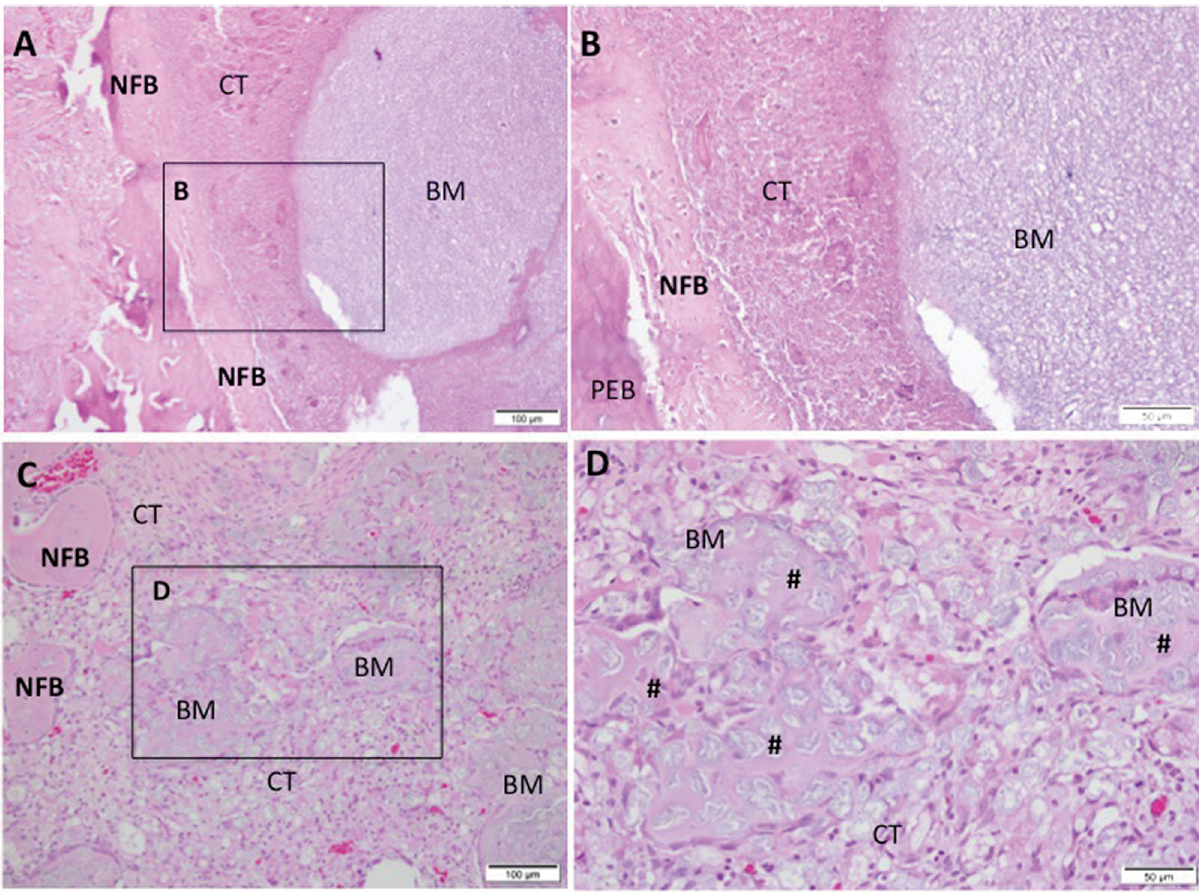
Figure 3- Representative photomicrographs of alveolar socket after 7 days. A and B: CHA group and C and D: SrCHA group. In A and B: presence of connective tissue surrounding the biomaterial (BM) microsphere and peripheric newly formed bone (NFB). C and D: presence of newly formed bone surrounding the connective tissue area, containing particulate biomaterial with peripheric osteoid (#). Square with 40-fold magnification taken from A and C, respectively. NFB: Newly Formed Bone; BM: Biomaterial; CT: Connective Tissue; #: Osteoid. Hematoxylin and eosin stained. Bar: A and C: 100 µm; B and D: 50